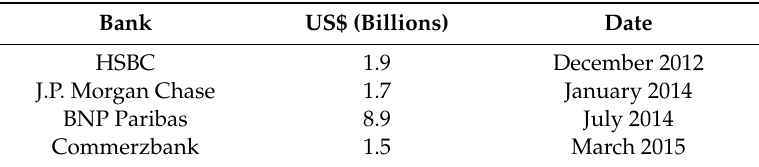
Table 1. Fines and penalties imposed for